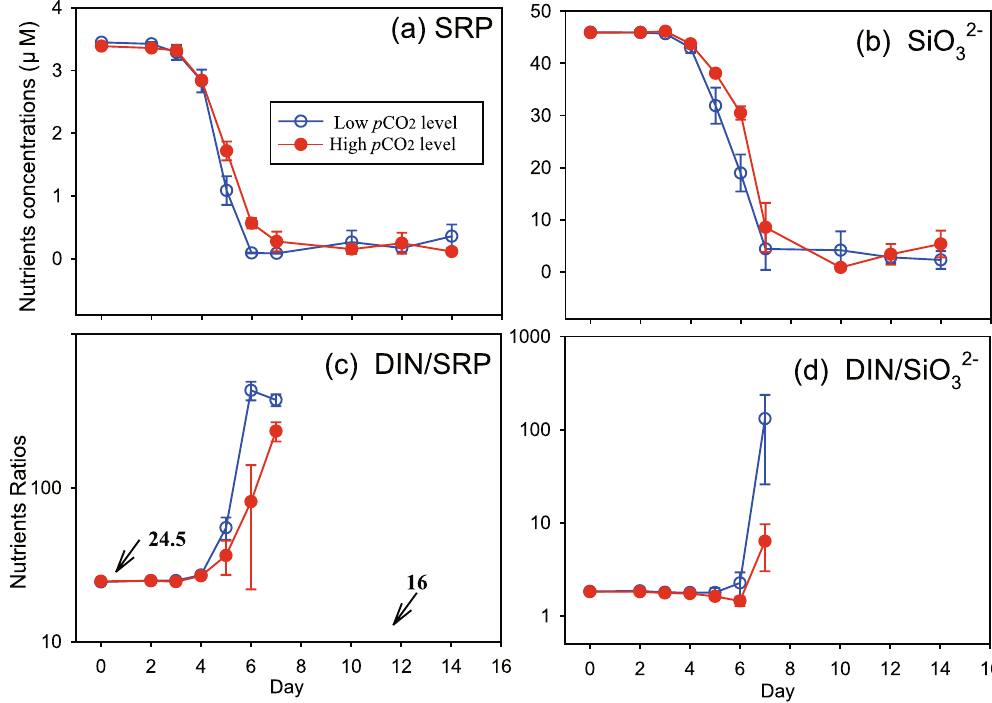
Figure 4. Temporal variations of concentrations of soluble reactive phosphorus (SRP, panel a), dissolved silicate, SiO 32 − ( b ), and ratios of dissolved inorganic nitrogen to soluble reactive phosphorus ( c , DIN/SRP) and to SiO 32 − ( d , DIN/SiO 32 − ) in 6 seawater enclosures which were perturbed by bubbling with ambient air (400 ppmv CO 2 , Low CO 2 level) or an air/CO 2 mixture at a concentration of 1000 ppmv CO 2 (High CO 2 level). Symbols are the means and error bars are the standard errors of three replicate enclosures. Nutrients ratio are shown during the nutrients replete period (day 0–7).